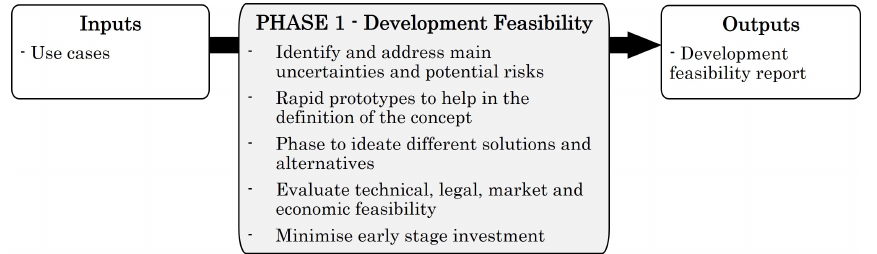
Figure 10. Development Feasibility phase: key characteristics, inputs and